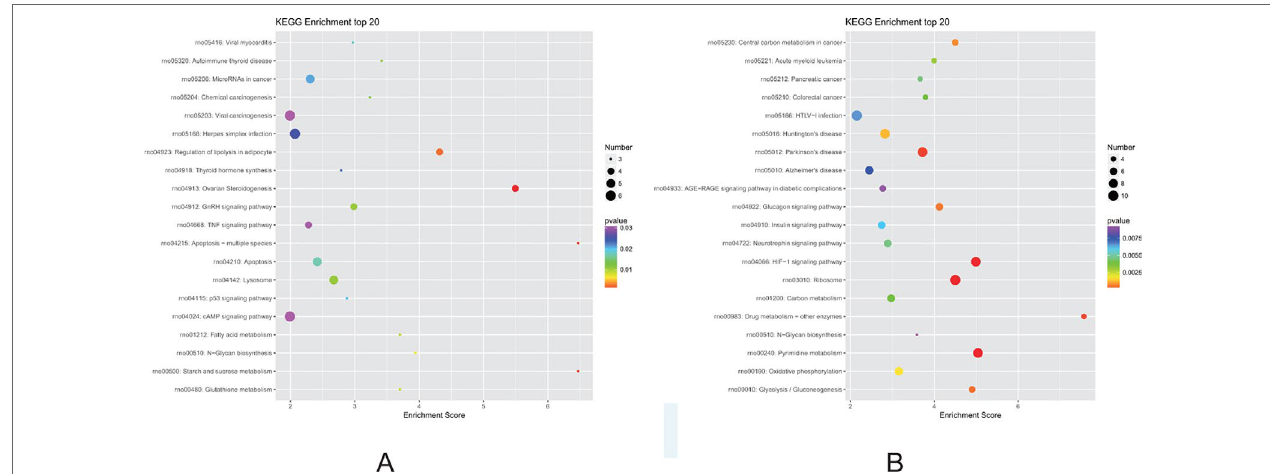
FIGURE 7 | Kyoto Encyclopedia of Genes and Genomes (KEGG) pathway analysis for DEGs. (A) Pathways corresponding to DEGs from the air-control F1 versus hypoxia F1 rats. (B) Pathways corresponding to DEGs from the air-control F2 versus hypoxia F2 rats.